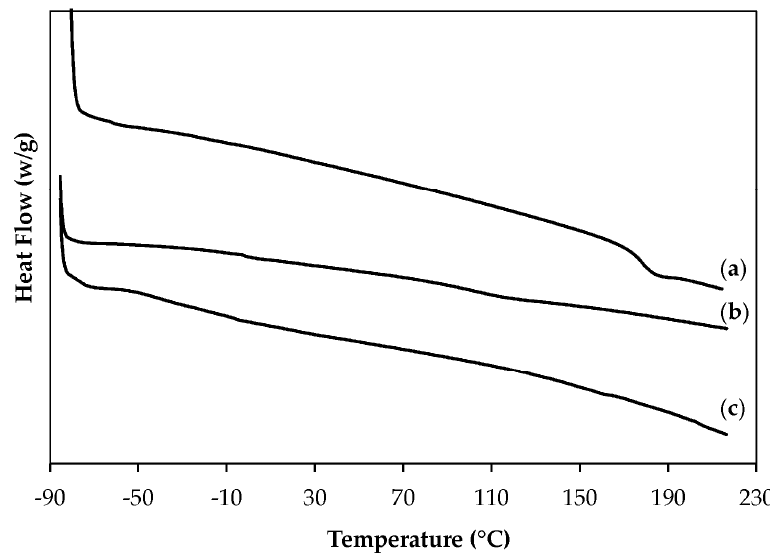
Figure 6. Differential Scanning Calorimetry (DSC) thermograms of ( a ) PNVCL–OH, ( b ) PNVCL- b -PCL (1) and ( c ) PNVCL- b -PCL (2).